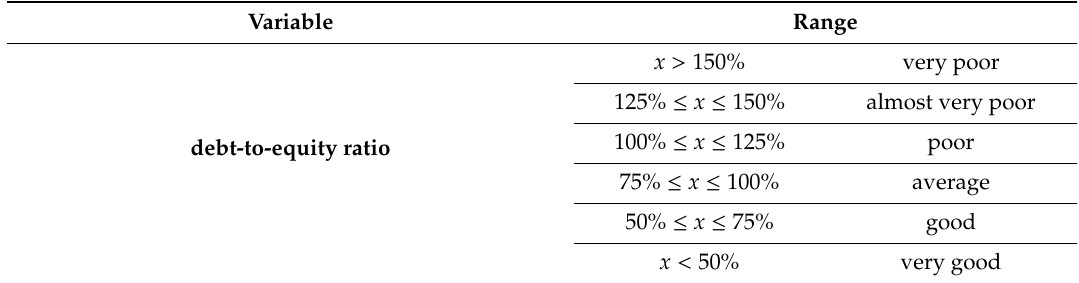
Table 4. Ranges of each variable and relationships to linguistic